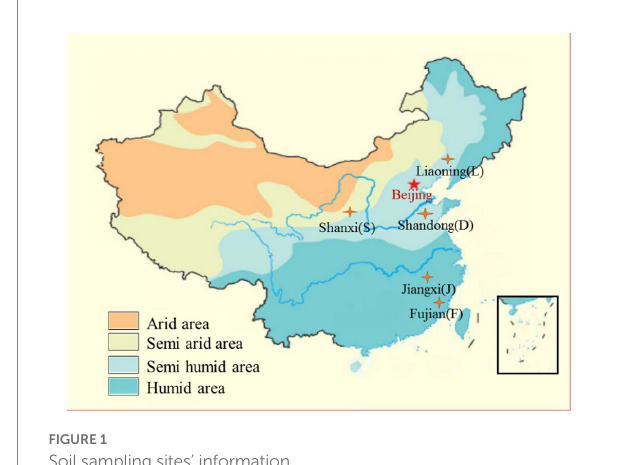
FIGURE 1 Soil sampling sites’